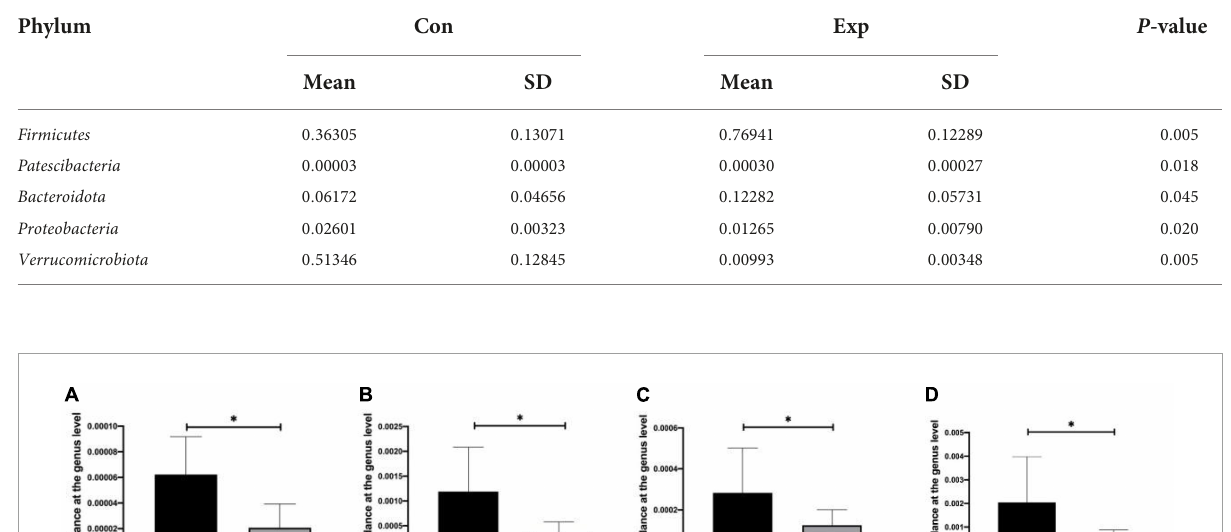
TABLE 3 The operational taxonomic unit (OTU) abundance differences at the phylum level.